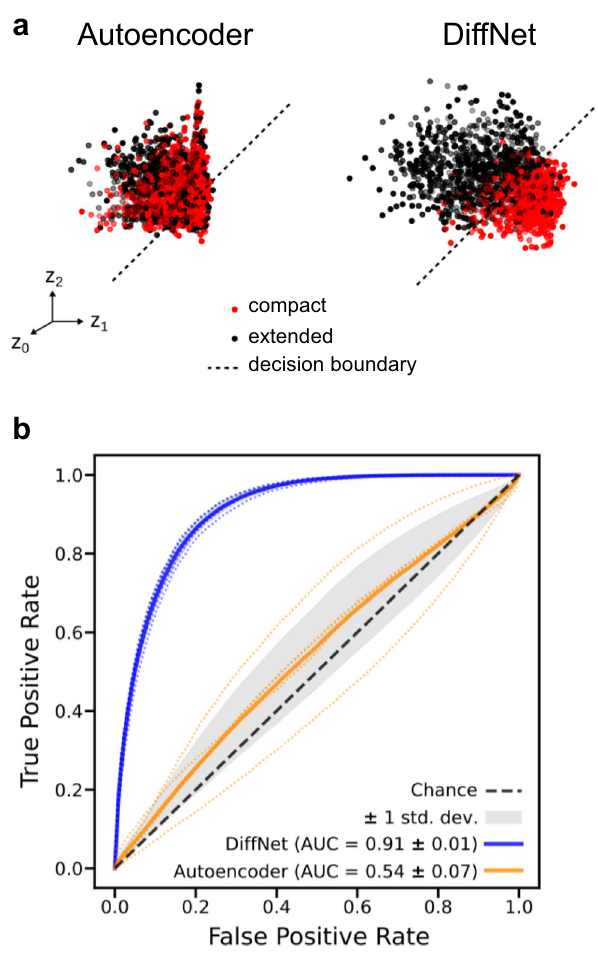
Fig. 4 Adding a classi fi cation component to the learning task (as in DiffNets) results in a latent representation that separates different datasets more clearly than an unsupervised autoencoder. a Simulation frames that have a compact helix (red) and an extended helix (black) are projected onto the three-dimensional latent space learned by an unsupervised autoencoder (left) and a DiffNet (right). The decision boundary (black dotted line) indicates the plane that each neural network uses to separate compact helix states from extended helix states. b Receiver operating characteristic (ROC) curve showing the average classi fi cation performance of the unsupervised autoencoder (dark yellow) and the DiffNet (dark blue) as well as the performance for each of the 5 folds of cross validation (faded dotted lines). Mean area under the ROC curve (AUC) is shown in the bottom right corner with the standard deviation across the 5-folds of